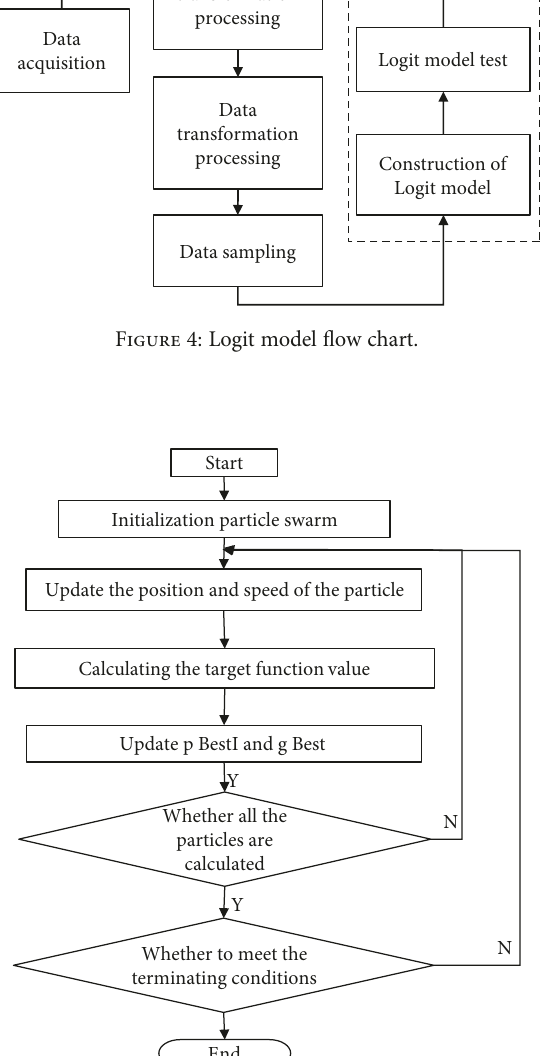
Figure 5: Flow chart of the standard particle swarm optimization